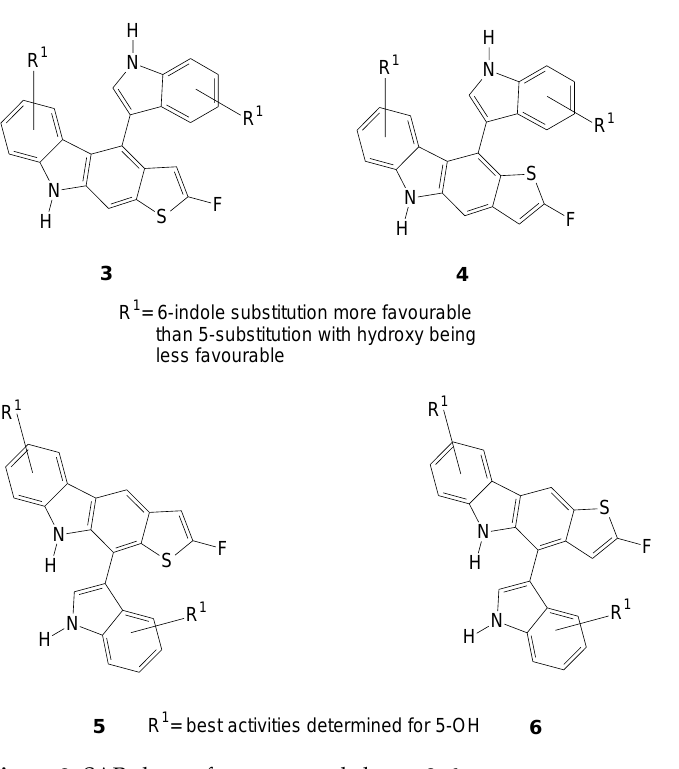
Figure 2. SAR shown for compound classes 3 – 6 .